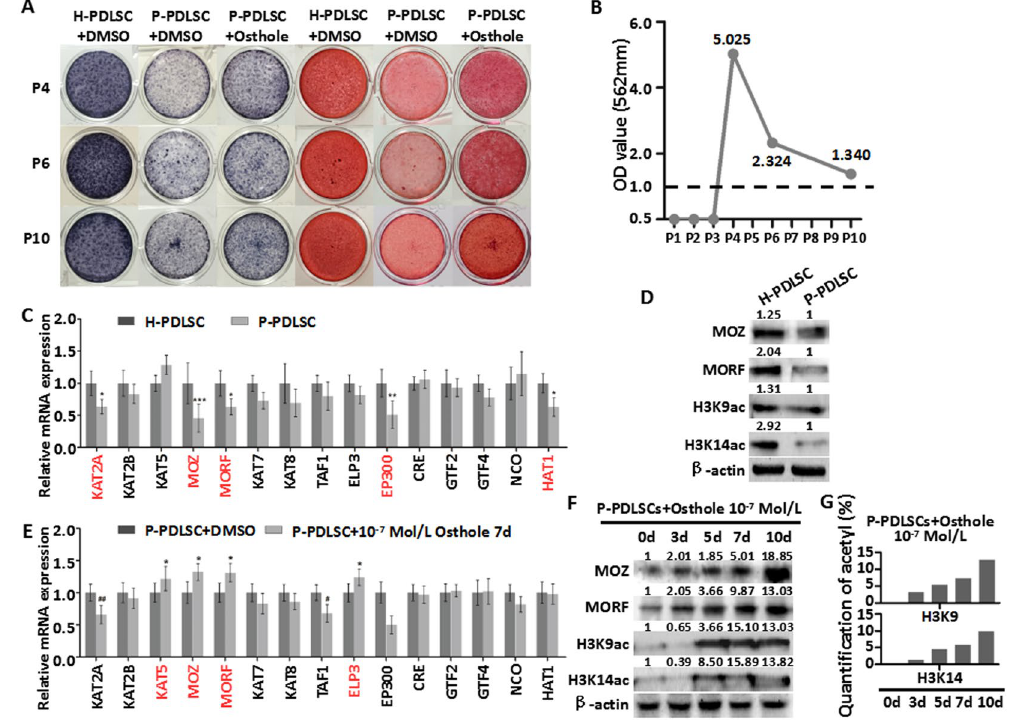
Figure 2. Osthole reverses defective osteogenesis of P-PDLSCs through histone acetylation. ( A ) ALP staining and ARS staining of H-PDLSCs, P-PDLSCs and P-PDLSCs with 10 − 7 Mol/L Ostholes in P4 (with stimulation), P6 (without stimulation) and P10 (without stimulation). ( B ) Quantification of ARS staining for light absorbance at 562 nm. ( C ) qRT-PCR showed gene expression of fifteen histone acetylases in H-PDLSCs and P-PDLSCs. ( D ) Protein expression of MOZ, MORF, H3K9ac and H3K14ac in H-PDLSCs and P-PDLSCs as assayed by western blot. ( E ) qRT-PCR showed gene expression of fifteen histone acetylases in P-PDLSCs and P-PDLSCs with 10 − 7 Mol/L Osthole measured by qRT-PCR. ( F ) Protein expression of MOZ, MORF, H3K9ac and H3K14ac in P-PDLSCs with 10 − 7 Mol/L Osthole treatment on day 0, 3, 5, 7, 10 as assayed by western blot. ( G ) Level of acetylation of H3K9 and H3K14 in P-PDLSCs with 10 − 7 Mol/L Osthole treatment on day 0, 3, 5, 7, 10 as assayed by EpiQuik Global Acetyl Histone Quantification Kit. * P < 0.05, ** P < 0.01, *** P < 0.001, no mark: P ≧ 0.05, n =